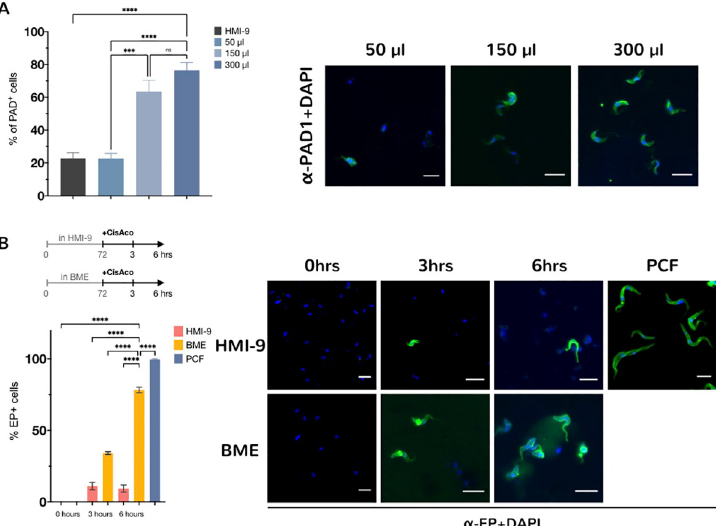
Fig 2. Expression of the PAD1 marker is dependent on BME concentration. (A) T . brucei AnTat1.1 90:13 cells were grown in the presence of increasing concentrations of BME and samples were taken at 72 hrs. Increasing the concentration of substrates leads to a higher percentage of cells expressing the stumpy marker PAD1. 200 cells counted per condition ( ���� P < 0.0001, ��� P < 0.0002, n.s: not significant; one-way analysis of variance with Tukey’s multiple comparisons test). The right-hand panel shows representative immunofluorescence images for cells cultured in the presence of different concentrations of BME with PAD1 pseudo-coloured in green and DAPI (nucleus and kinetoplast) in blue. Scale bars, 10 μ m. (B) Expression of EP procyclin after incubation with either HMI-9 alone or BME for 72 hrs and exposure to 6mM cis-aconitate for 0, 3 or 6 hrs from the analysis of > 250 cells per condition. The stumpy form parasites obtained in BME express the EP procyclin protein to a higher level than cells isolated from HMI9. Procyclic form cells (PCF) are included as a positive control. Error bars = S.E.M. ( ���� P < 0.0001; one-way analysis of variance with Tukey’s multiple comparisons test). The right-hand panel shows representative immunofluorescence images of EP+ cells (in green) after exposure to cis-aconitate. The parasite nucleus and kinetoplast (stained with DAPI) is pseudo-colored in blue. Scale bars, 10 μ m.